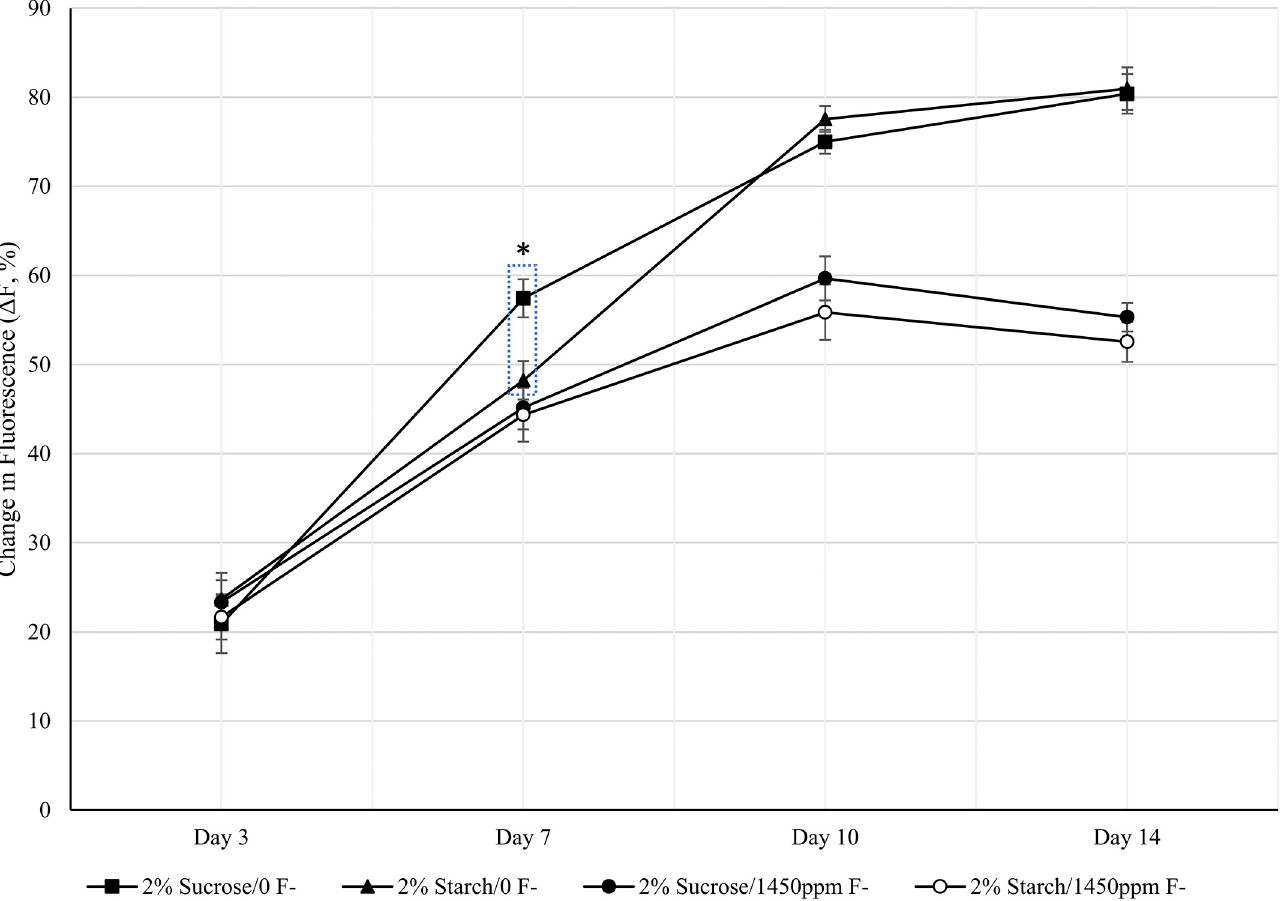
Fig 4. Changes in fluorescence. Change in Δ F (%) over 14-days of exposure to 2% sucrose or 2% starch eight times daily. Two CDFF units were exposed to 1450 ppm F- and two units had no additional F-. Error bars represent standard error of the sample set. � Denotes significance.